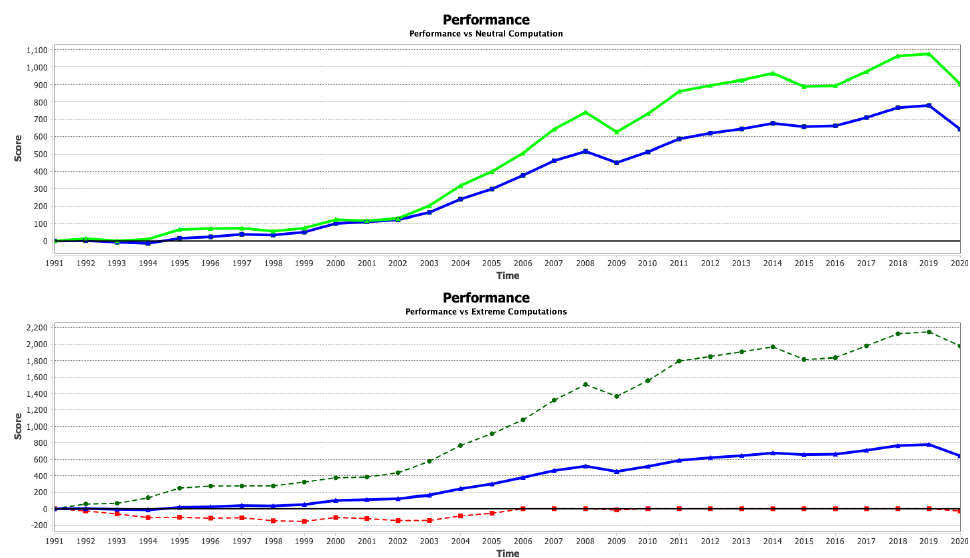
Figure 12. Analysis result (Case Study 1). The system performance is represented by the blue line, while the continuous green line refers to the neutral computation. Dashed lines are extreme